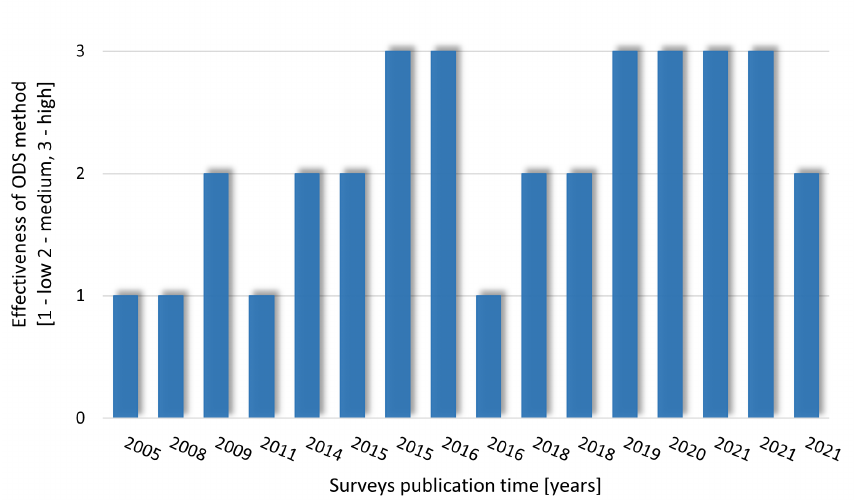
Figure 10. Effectiveness of ODS in time, where 1 is low, 2 is medium and 3 is high efficiency. The constant development of ODS is noticeable, caused mainly by increasing the computing power of control